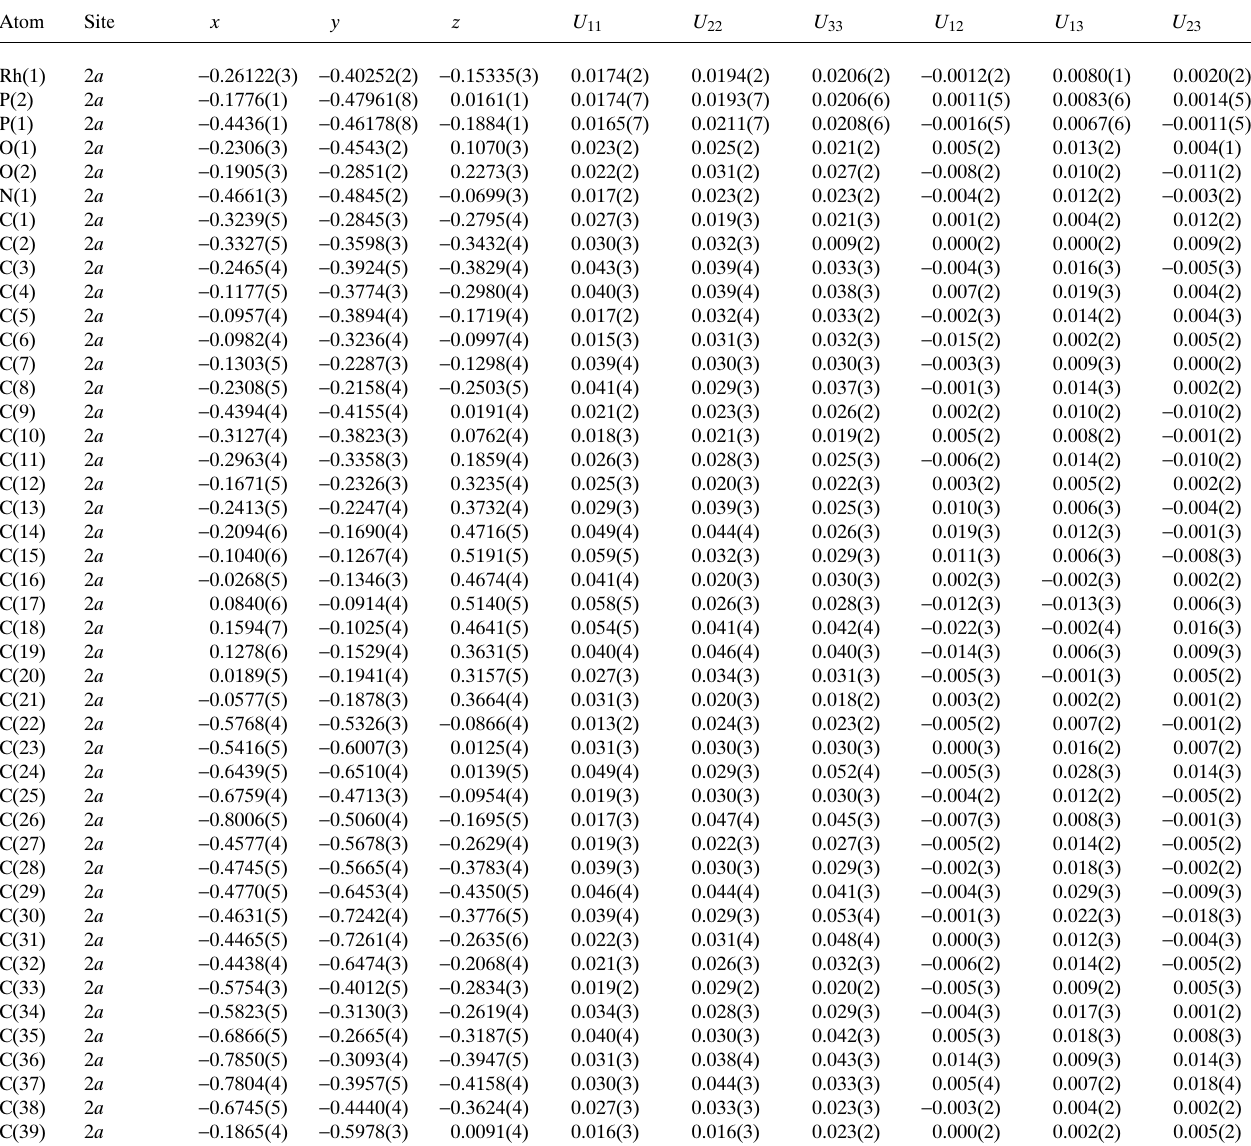
Table 3. Atomic coordinates and displacement parameters (in Å 2 )